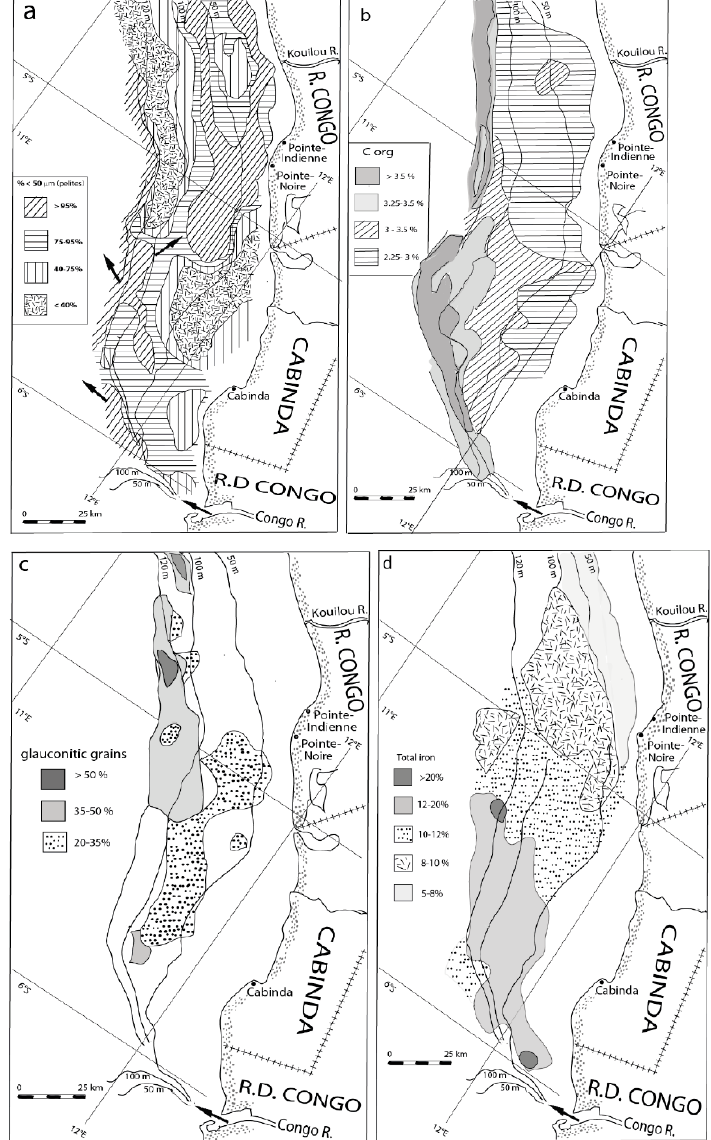
Figure 2. ( a ). Distribution map of the concentrations of pelitic matter (<50 μ m): >95%, 75%–95%, 40%–75%, 15%–40%, less than 15%. ( b ) Distribution map of the concentrations of total C org: > 3.5%, 3.25%–3.5%, 3%–3.25%, 2.25%–3% (redrawn from Giresse and Moguedet, [16]. ( c ) Distribution map of the high concentrations of glauconitic grains related to the sandy fraction of the sediment: >50%, 35%–50%, 20%–35%. ( d ) Distribution map of the total iron in the silty muds >20%, 12%–20%; 10%–12%; 8%–10%; 5%–8% (redrawn from Giresse, [1,2].